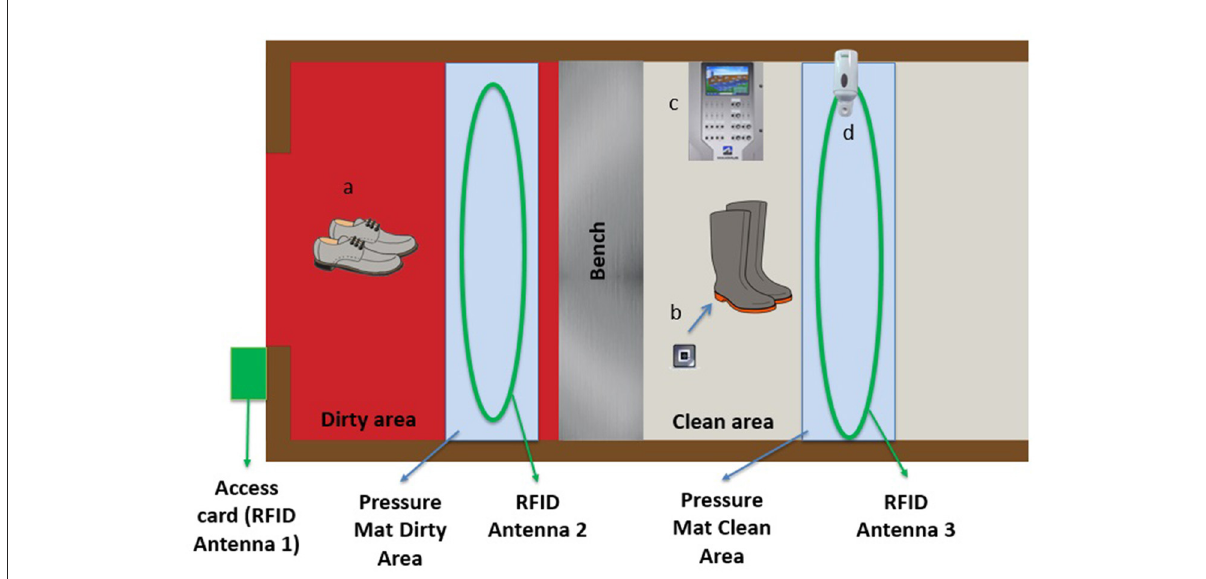
the frame of the exterior door identifying the person entering the barn (access card already used by employees), the second in the dirty area, allowing for the detection of chipped farm boots (indicating biosecurity non-compliance), and the third in the clean area, connected to the hand sanitizer, detecting hand sanitization when entering and leaving the clean area as well as the RFID chips in farm boots (indicating compliance with changing boots). Two pressure mats were also installed in the barn entrance (one in the dirty area and one in the clean area) to facilitate the detection of visitors, assess the direction of people (i.e., entering vs. leaving) and detect lack of compliance if farm boots were recorded in the clean area (Figure 4).